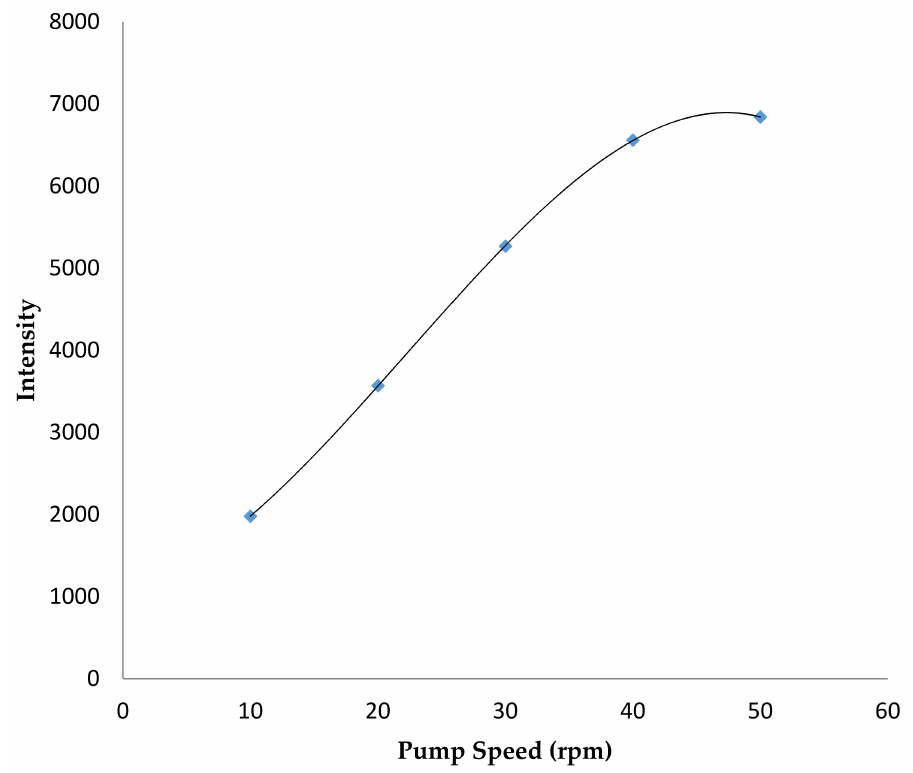
Figure 1. The effect of varying pump speed on the intensity of mercury emission at 253.652 nm.